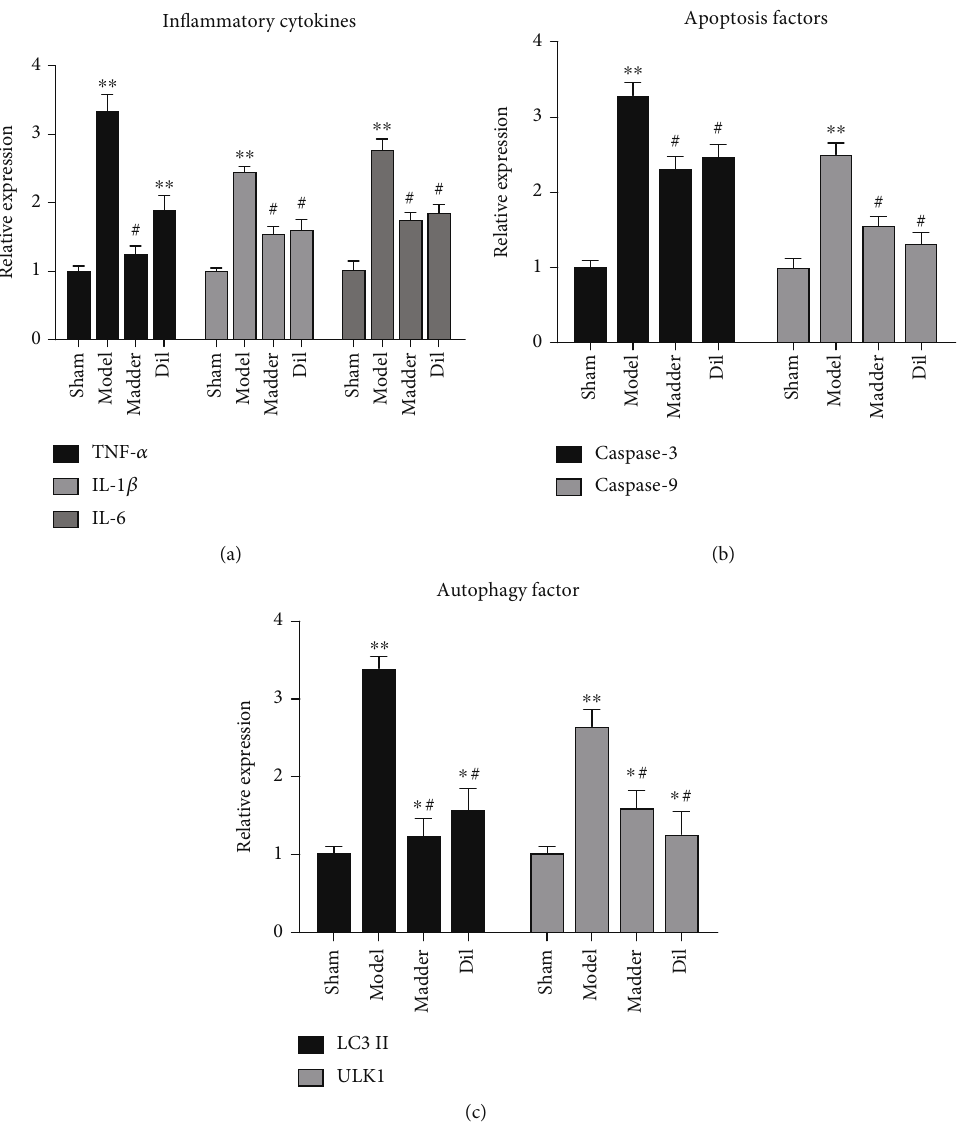
Figure 2: E ff ect of madder treatment on in fl ammatory response, autophagy, and apoptosis of myocardial cells: (a) the expressions of in fl ammatory cytokines TNF- α , IL-1 β , and IL-6 were detected by ELISA assay; (b) the expression changes of apoptosis for factors Caspase-3 and Caspase-9 were detected by ELISA assay; (c) ELISA assay was used to detect the expression changes of autophagy factors LC3-II and ULKI. ∗ P < 0 : 05and ∗∗ P < 0 : 01 , compared with the sham group; # P < 0 : 05 , compared with the model